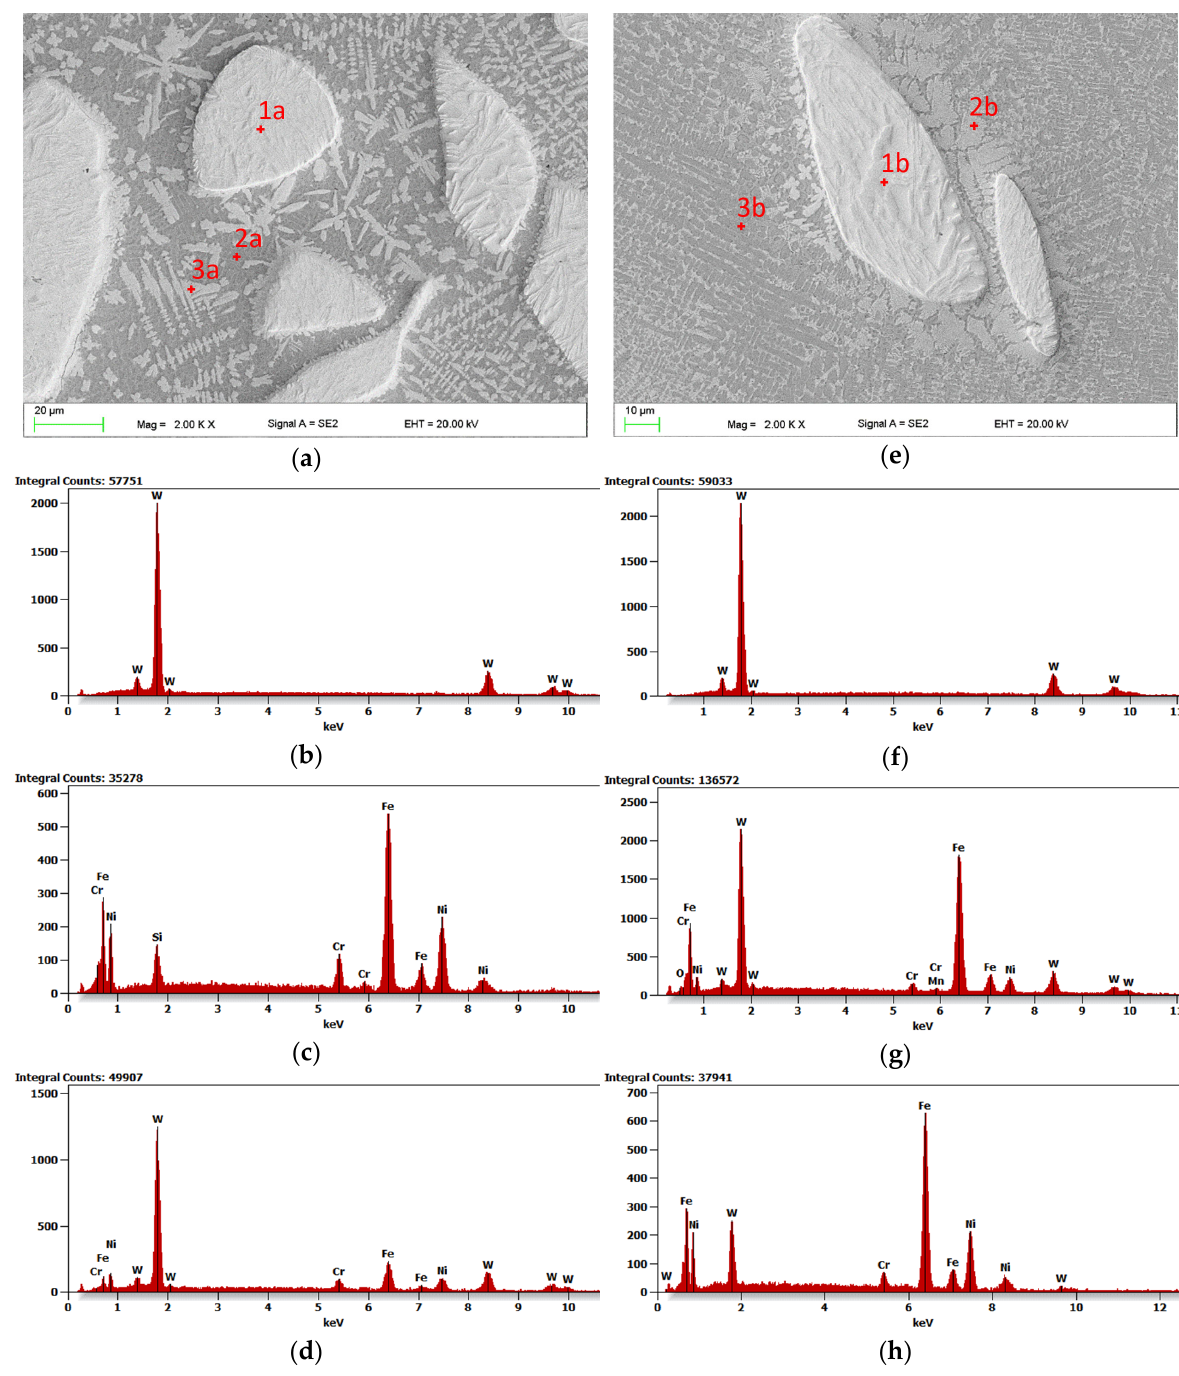
Figure 9. SEM micrographs of the comparative stringer beads produced by laser cladding of exper- imental composite NiCrBSi/WC + W 2 C powder: ( a ) at laser output power 1.0 kW, energy input 120 J/mm; ( e ) at laser output power 2.0 kW, energy input 240 J/mm, and representative EDS spectra taken from different regions; ( b – d ) and ( f – h ).